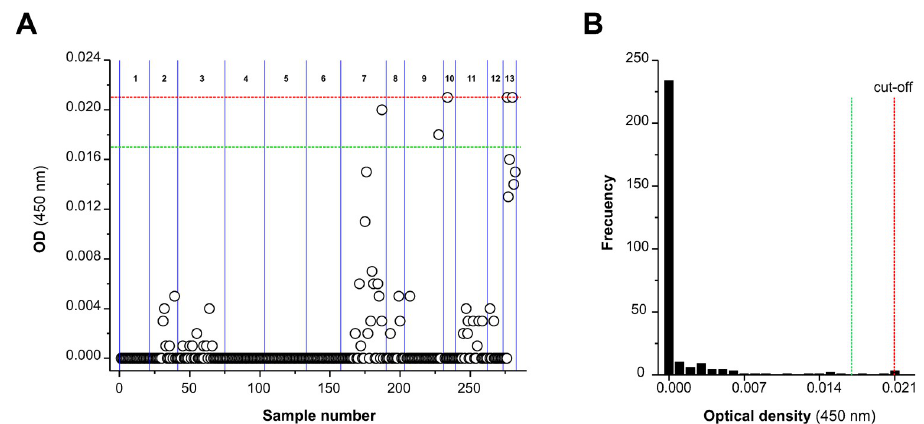
Fig 5. OD values of the ‘ Fasciola -infected’ flocks’ sheep that tested negative in both eMM3-COPRO and coproscopy. (A) Scatter plot showing the distribution of individual values and (B) diagram of frequencies (n = 282). Dashed red lines indicate the cut-off value (0.021). Dashed green lines indicate the maximum OD value (0.017) in the negative reference population. Solid blue lines indicate the separation between samples from different flocks (1–13).